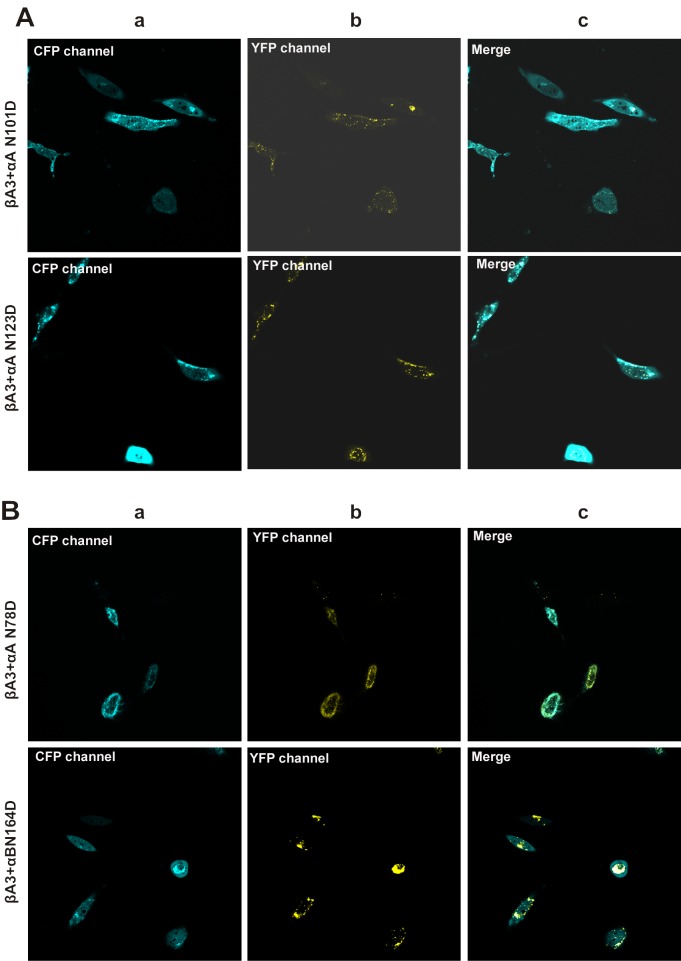
Confocal images of expression of deamidated mutants of αA- and αB-crystallins with βA3- crystallin in HeLa cells.Confocal microscopic images of HeLa cells co-transfected with: A. CFP βA3-crystallin-YFP αA N101D crystallin and YFP αA N123D crystallin B. CFP βA3-crystallin-YFP αB N78D crystallin and YFP αB N146D crystallin. Note the co-expression of CFP- and YFP-tagged crystallins. Panel a: CFP channel image of cells co-transfected with pairs of CFP- and YFP-fusion crystallins. Panel b: YFP channel image of cells co-transfected with pairs of CFP- and YFP-fusion crystallins. Panel c: Merged images for CFP and YFP channels of cells co-transfected with pairs of CFP- and YFP- fusion crystallin.